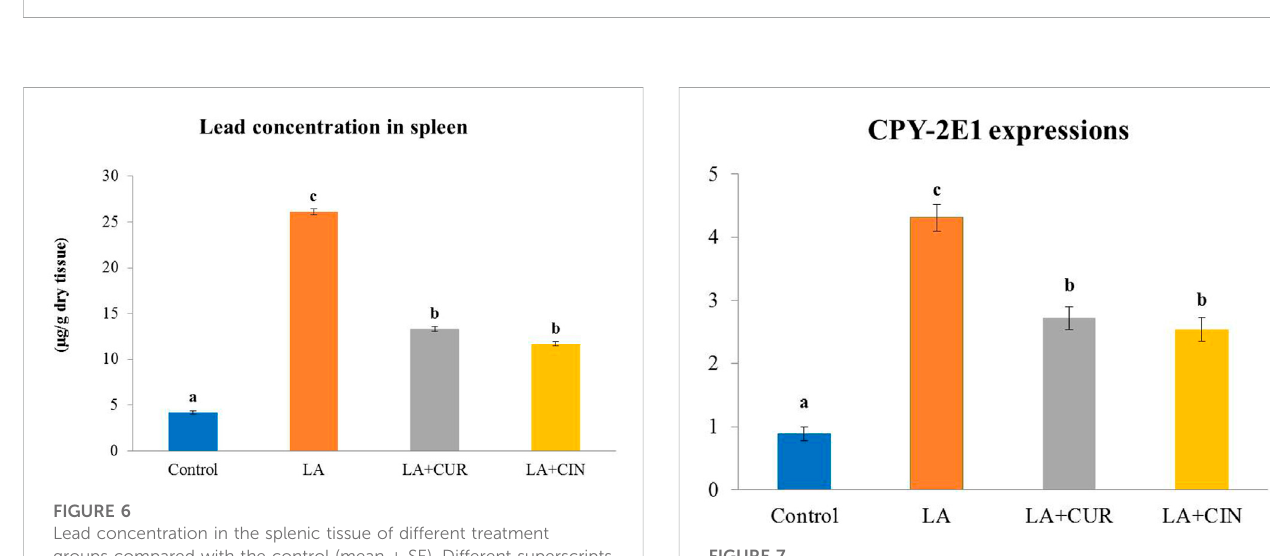
FIGURE 5 Changes of oxidative stress/antioxidant parameters in different treatment groups compared to the control (mean ± SE). Different superscript letters in each fi gure indicate signi fi cant differences at p < .05.